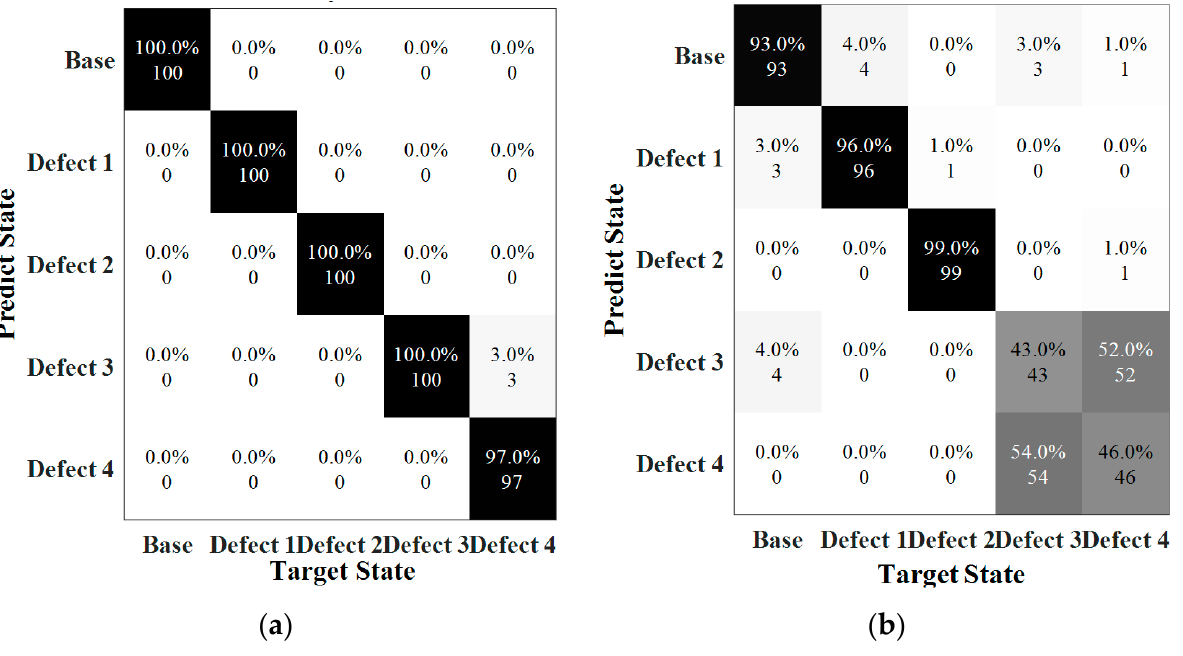
Figure 24. Testing results. ( a ) SNR = 70 dB (Accuracy = 99.4%). ( b ) SNR = 60 dB (Accuracy = 75.4%).